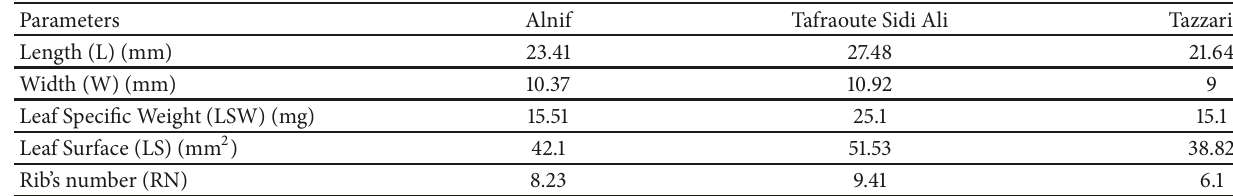
Table 2: Morphometric analysis studied of Henna varieties.